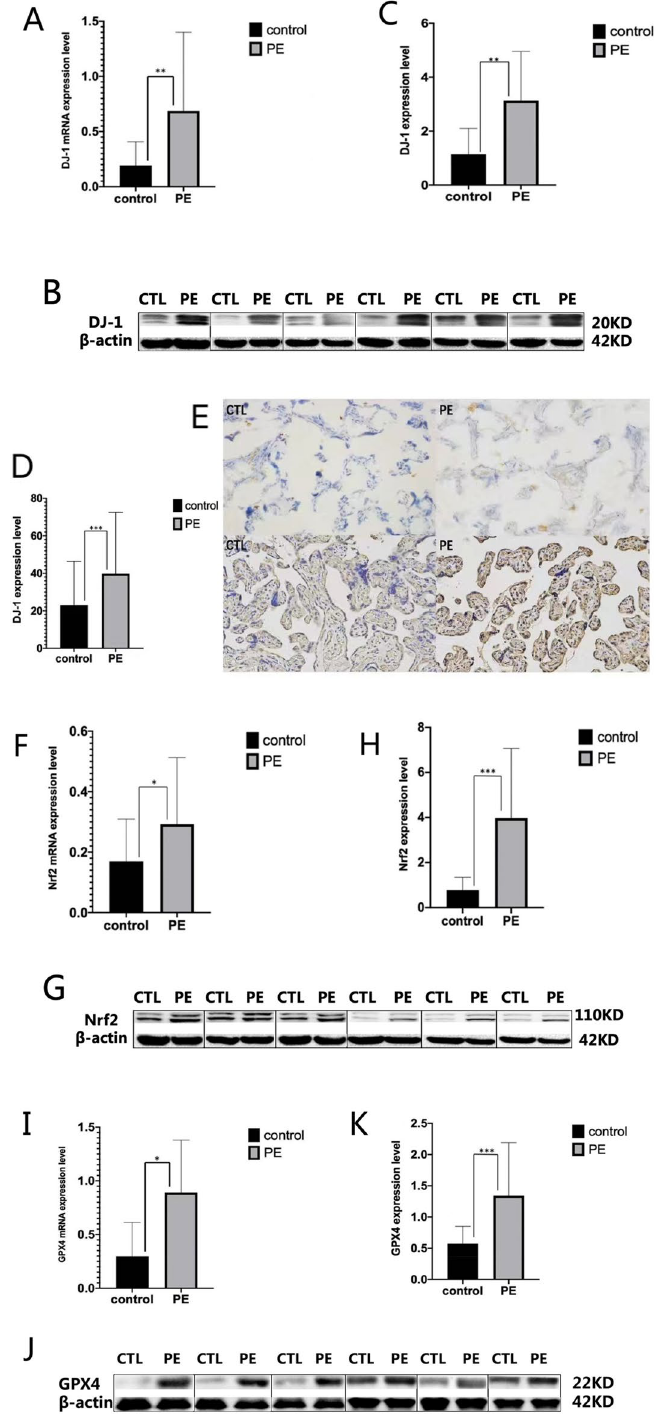
Figure 3. DJ‑1 and Nrf2/GPX4 signal pathway expression levels in placental tissue from normal and preeclamptic pregnancies. ( A , F , I ) In reverse transcriptase-polymerase chain reaction (RT-PCR), expression level of DJ-1, Nrf2 and GPX4 mRNA was significantly increased in PE group (P 1 = 0.005, P 2 = 0.022, P 3 = 0.029). ( B , C , G , H , J , K ) In Western Blot, expression level of DJ-1, Nrf2 and GPX4 protein was significantly increased in PE group (P 1 = 0.005, P 2 < 0.001, P 3 < 0.001). ( D , E ) In immunohistochemistry, expression level of DJ-1 protein was significantly increased in PE group (p < 0.001). Comparison between two groups was conducted by the independent sample